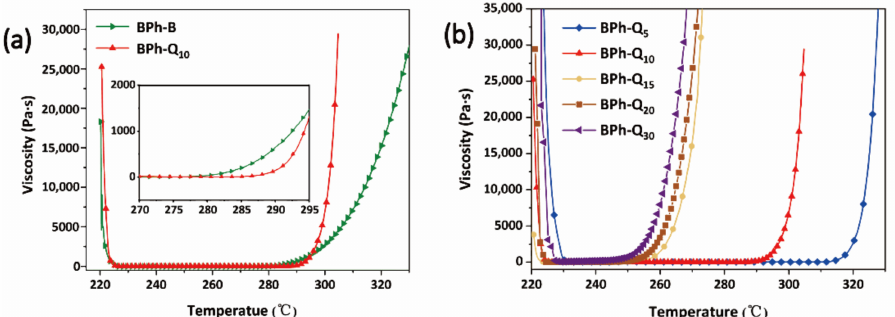
Figure 4. Rheological curves of ( a ) BPh-Q 10 and BPh-B prepolymers, ( b ) BPh-Q 5 , BPh-Q 10 , BPh-Q 15 , BPh-Q 20 and BPh-Q 30 , Rheological analyses are performed from 220 to 400 ◦ C at a heating rate of 2 ◦